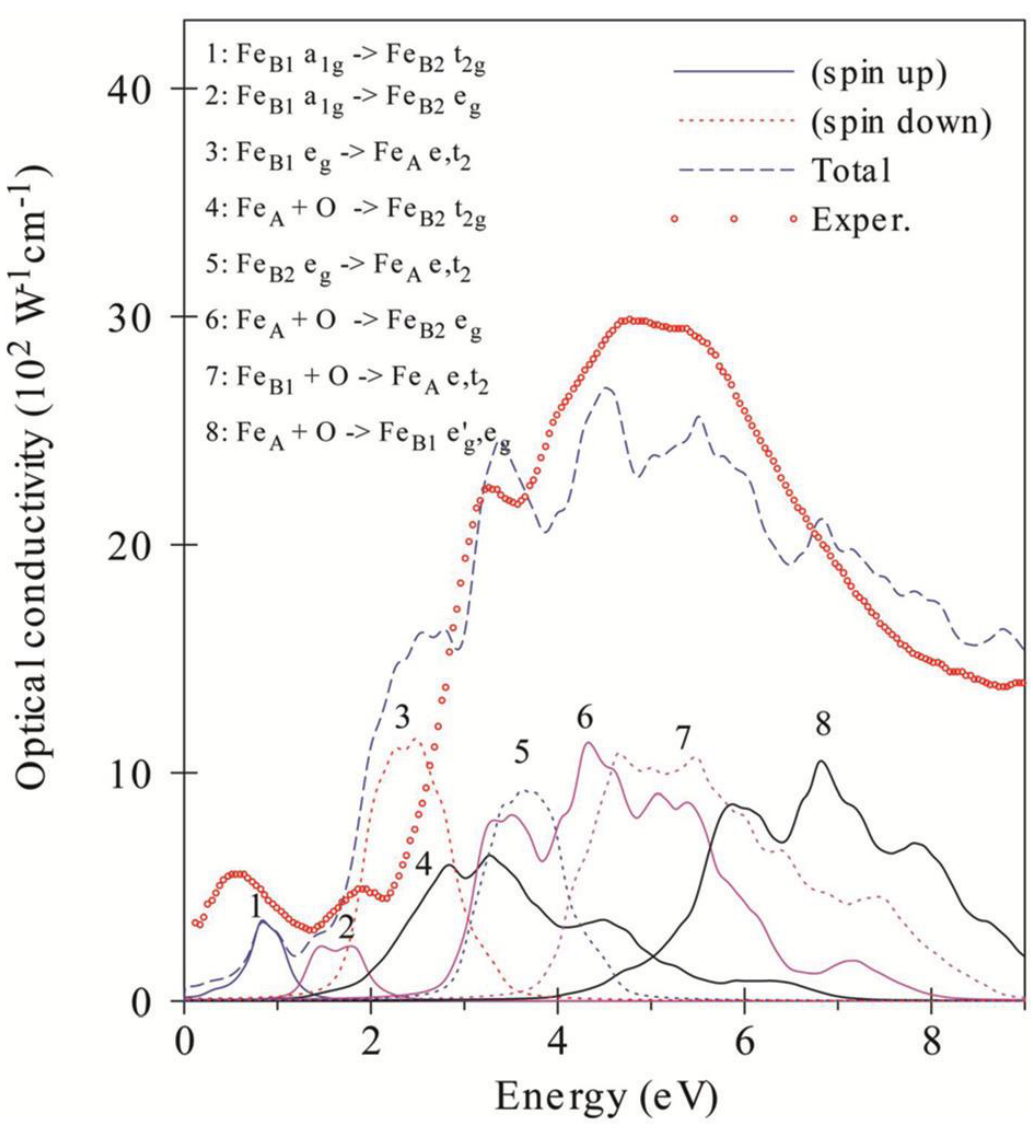
Figure 3. Various inter-band transitions in relation to the absorptive section of the diagonal optical conductivity of magnetite [39]. The circles depict experimental data reported by Park et al. [40]. [Reprinted with permission from Antonov et al. [39] and Park et al. [40]. Copyright 1998 and 2001 American Physical Society].